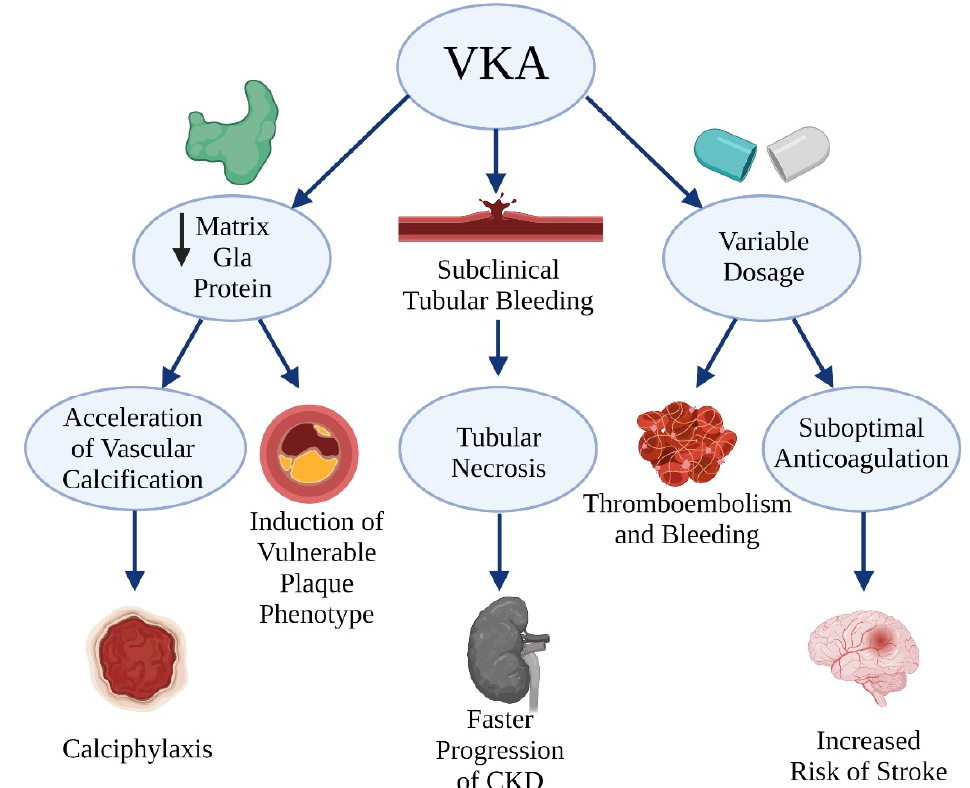
Figure 2. Disadvantages of treatment with vitamin K antagonists in chronic kidney disease (CKD). Created with BioRender.com.